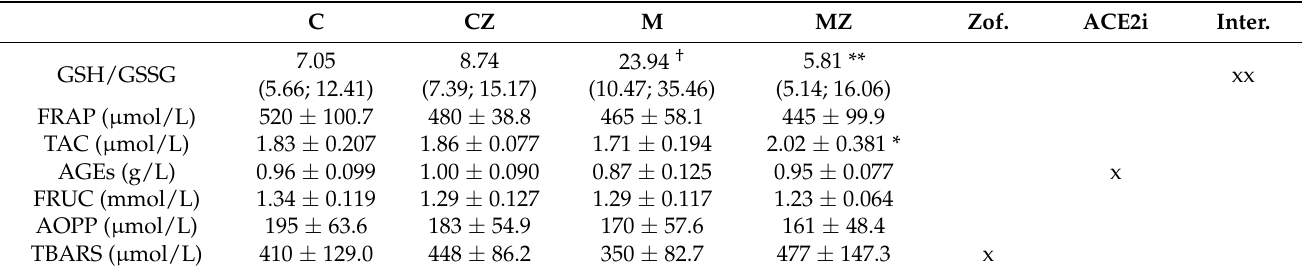
Table 3. The ratio of GSH/GSSG and the concentration of FRAP, TAC, AGEs, FRUC, AOPP and TBARS in the plasma samples.